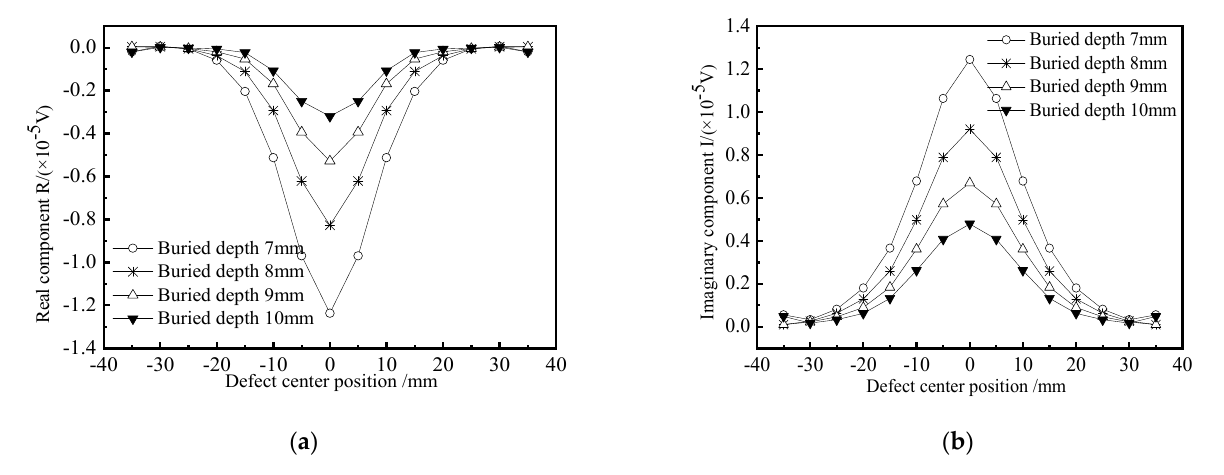
Figure 17. Crack defect detection signals at different buried depths. ( a ) Real component; ( b ) Imagi- nary component.